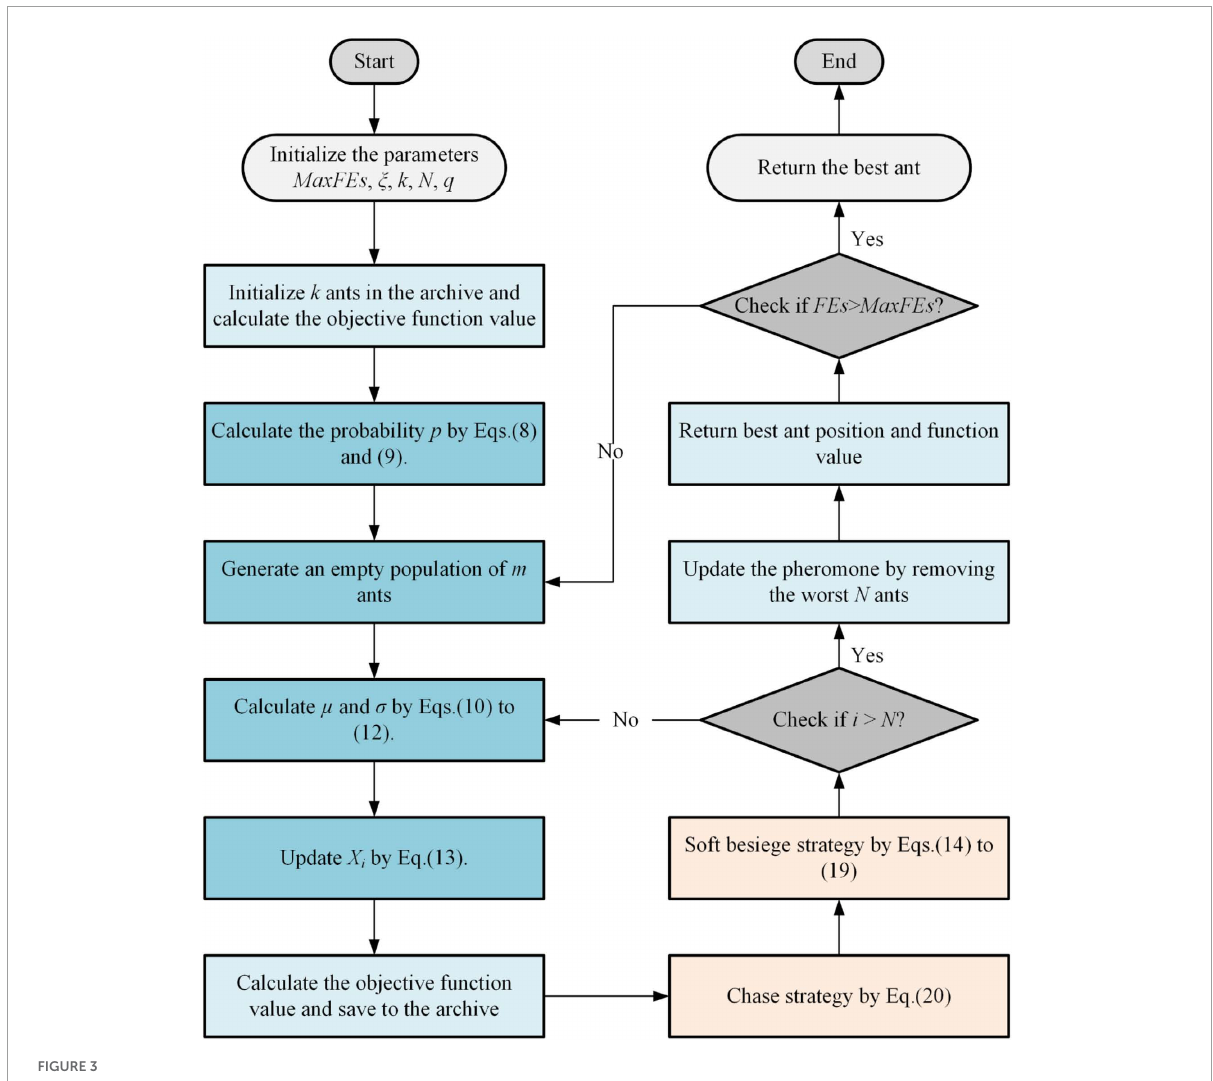
FIGURE3 Flowchart of